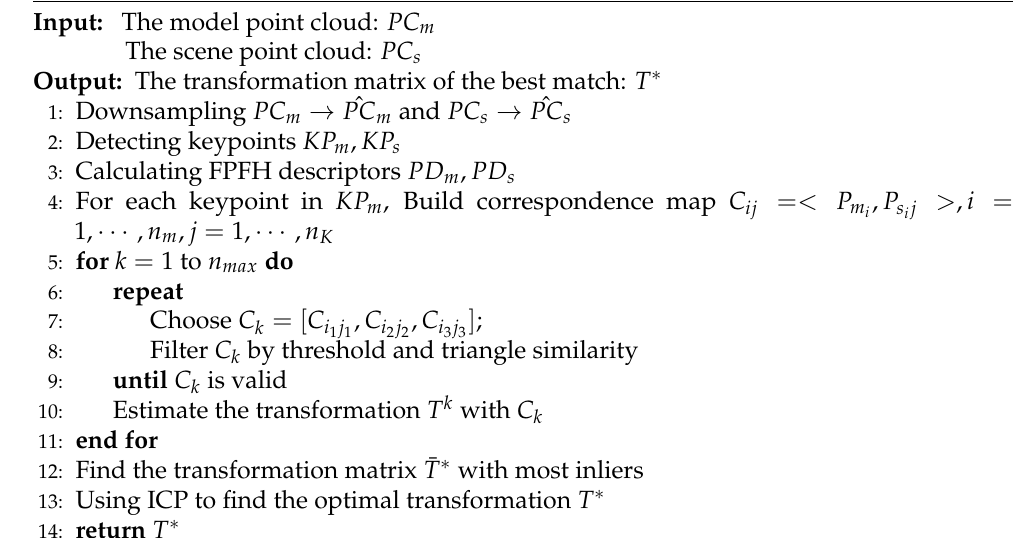
Algorithm 2 Efficient SAC-IA Pose Estimation Algorithm.